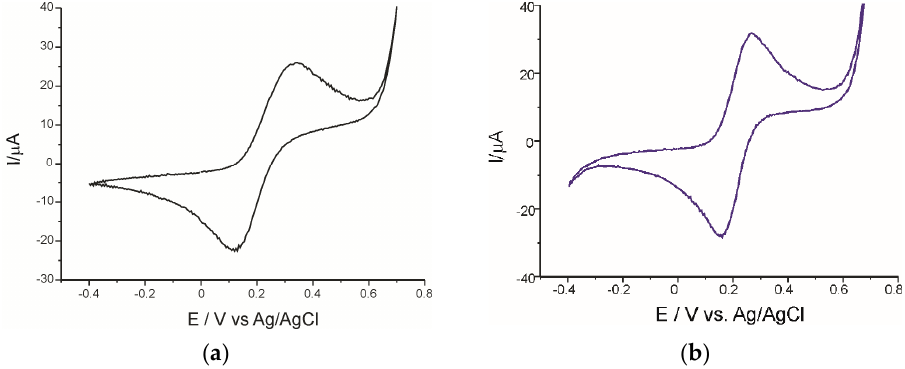
Figure 1. Cyclic voltammograms of the SPCE ( a ) and AuNP-CNT/SPCE ( b ) electrodes in 10 − 3 M of